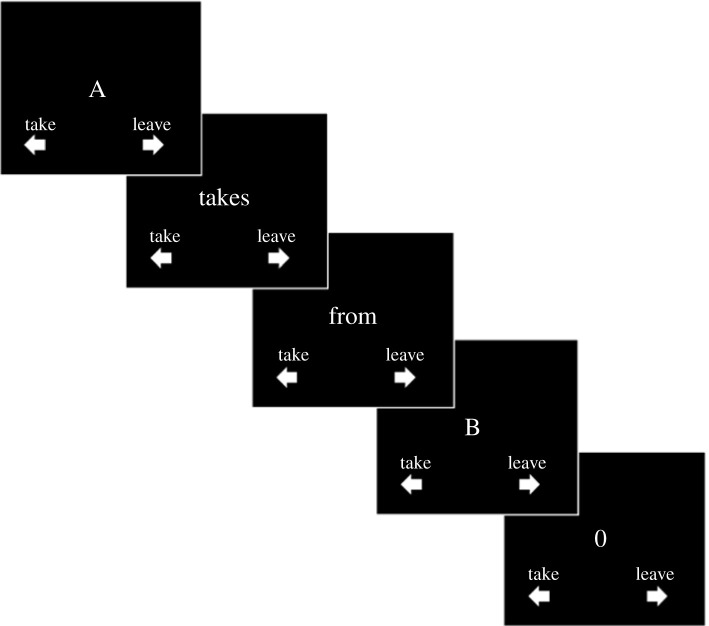
In this example trial, A decided to take 0 (no chips) from B, so they both ended the game with 200 chips each.